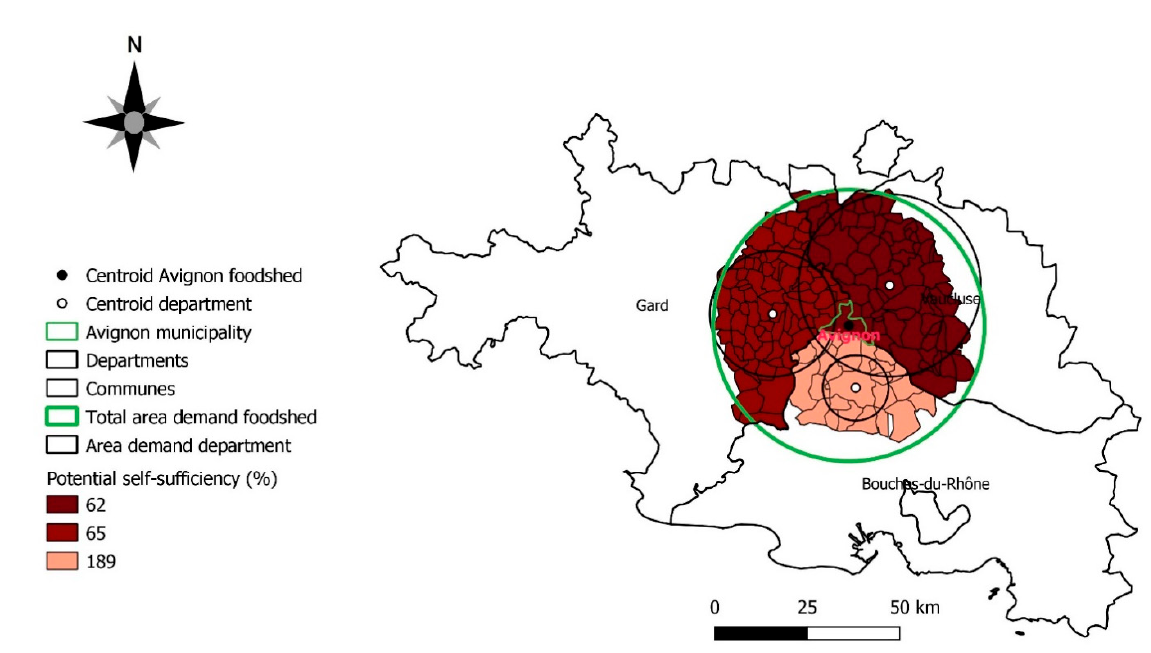
Figure 4. Mapping of the area demand (circles, in km) and food self-sufficiency (colors, expressed in %) for three departments (black) and for the whole foodshed proposed (green) based on the 30 km radius recommendation by the French Senate. See Table 1 for the specific values of the radius and area demand.